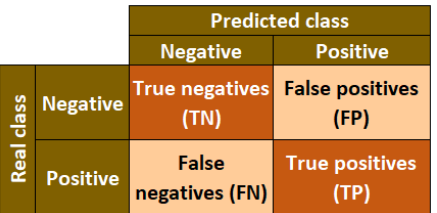
Figure 6. Structure of a confusion matrix for two classes.